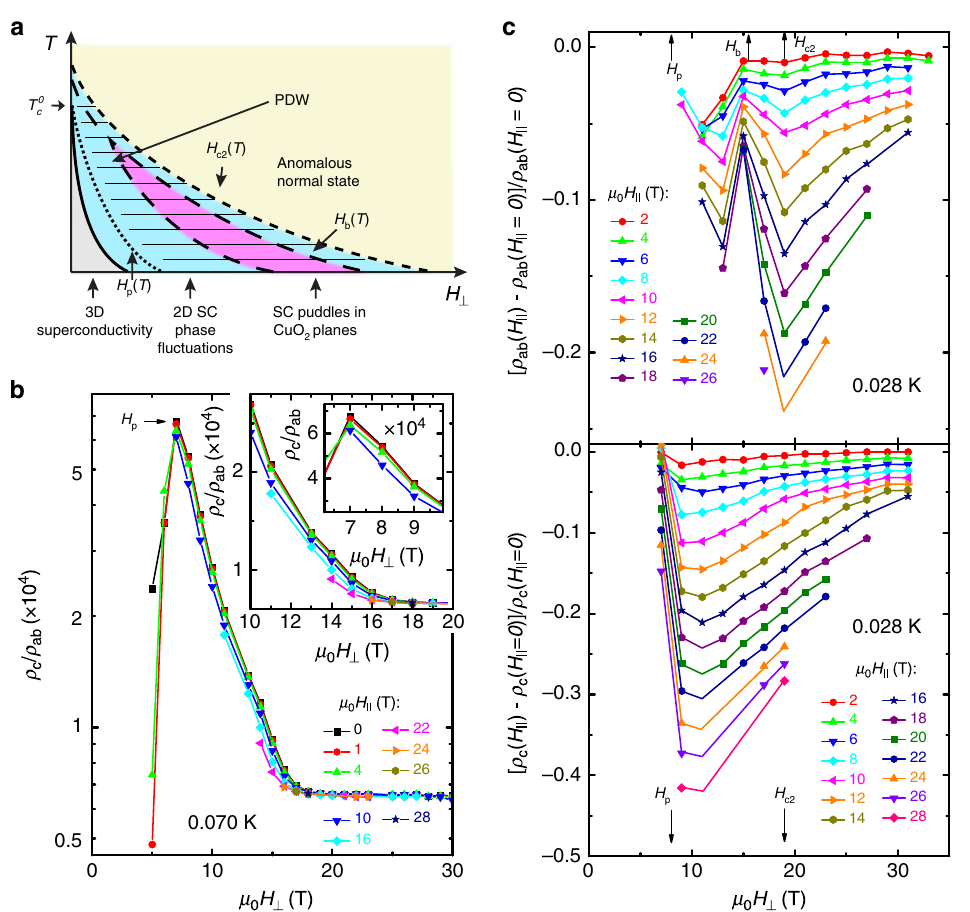
Fig. 3 Evidence for a PDW from anisotropic transport. a Schematic T – H ⊥ phase diagram. H ⊥ suppresses the 3D superconductivity (gray) and decouples (dotted line) the CuO 2 layers at H ⊥ = H p ( T ). Strong SC phase fl uctuations persist in the planes up to H c2 ( T ) (short-dashed line). The behavior in the pink region, the precursors of which appear already in H = 0 at T > T 0 (see dashed lines), is consistent with the presence of SC puddles in CuO 2 planes. c An additional, in-plane fi eld enhances the interlayer coupling for H p ( T ) < H ⊥ < H c2 ( T ), consistent with the presence of PDW correlations (thin hatched lines). Except for the thick solid line, other lines do not represent phase boundaries, but correspond to fi nite-temperature crossovers. b ρ c / ρ ab (for La 1.7 Eu 0.2 Sr 0.1 CuO 4 in-plane sample B1) vs. H ⊥ for different H ∥ , as shown, at T = 0.070 K. Larger inset: Enlarged view of the same data shows the suppression of the anisotropy by H ∥ for H p < H ⊥ < H c2 . Smaller inset: ρ c / ρ ab is reduced by ~10% near H p by H ∥ up to 10 T. c The corresponding [ ρ ab ( H ∥ )/ ρ H ∥ = 0) − 1] (top, sample B1) and [ ρ H ∥ )/ ρ H ∥ = 0) − 1] (bottom) vs. H ⊥ at T = 0.028 K for different H ∥ , as shown. In all panels, solid lines guide ab ( c ( c ( the Our experiments are thus consistent with the presence of local in H = 0, which are PDW correlations (in puddles) at T > T 0 c overtaken by the uniform d-wave superconductivity at low T < T 0 . In transport, the PDW SC order becomes apparent when c the uniform d-wave order is suf fi ciently weakened by H ⊥ : it appears beyond the melting fi eld of the vortex solid, within the vortex liquid regime, i.e. in the regime of strong 2D phase fl uctuations. Higher fi elds H p are needed to decouple the layers in H H ⊥ (< c2 ), the system seems to break up into SC puddles with the PDW order. However, the fi nal and key test of the presence of a PDW requires the application of a suitable perturbation, in particular H ∥ , to reduce the interlayer frustration and decrease the anisotropy 5 . Effects of H on the anisotropy . We have performed angle- ∥ dependent measurements of both ρ ab ( H ) and ρ c ( H ), where the angle θ is between H and the crystalline c -axis. This has allowed us to explore the effect of in-plane fi elds H k ¼ H sin θ at different